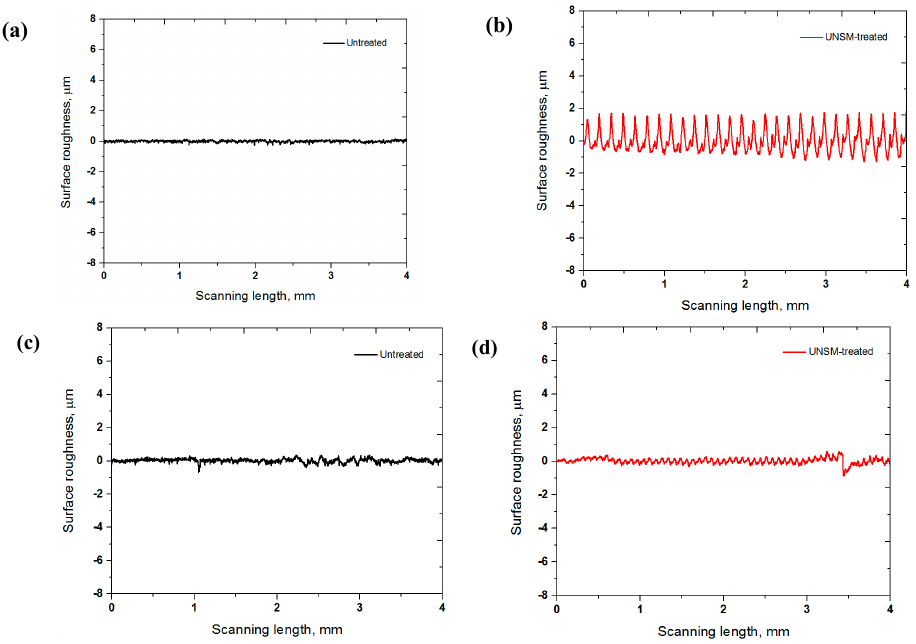
Figure 5. Comparison of surface roughness of the bulk ( a , b ) and 3D-printed ( c , d ) AISI H13 tool steel specimens before and after UNSM treatment.